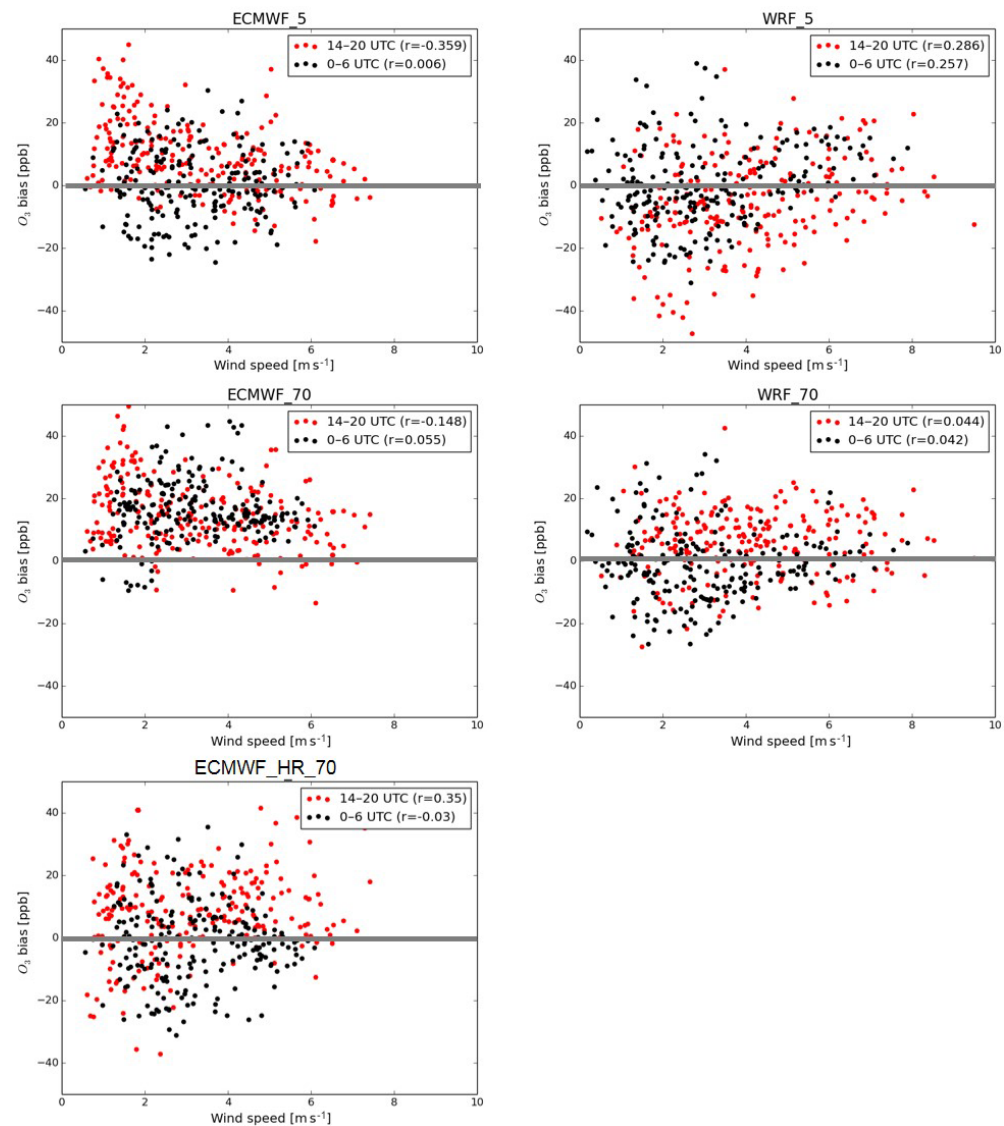
Figure 2. Correlation plots between the LOTOS-EUROS bias of surface O 3 and simulated wind speed at the station of Retiro disaggregated in 2d periods: 00:00–06:00 and